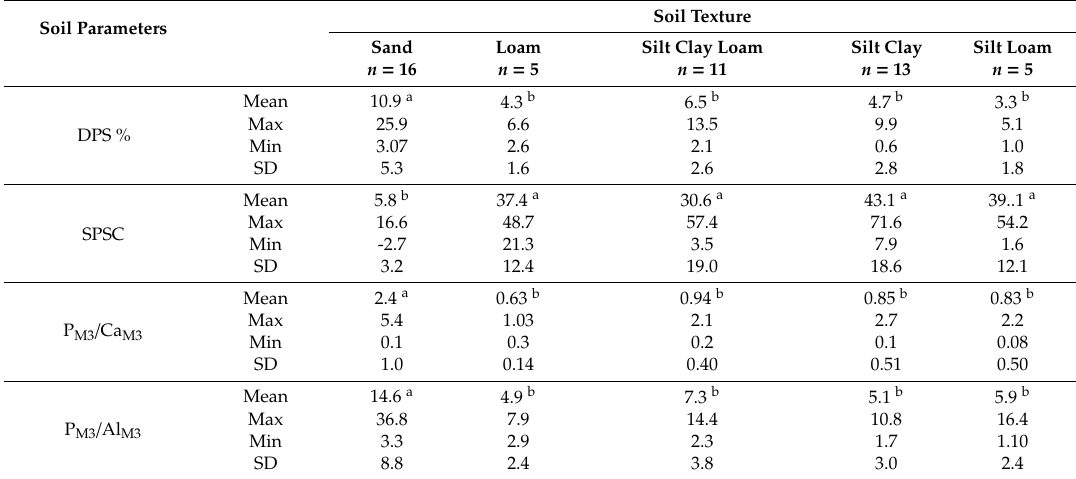
Table 3. P sorption parameters for the di ff erent soil textures investigated in this